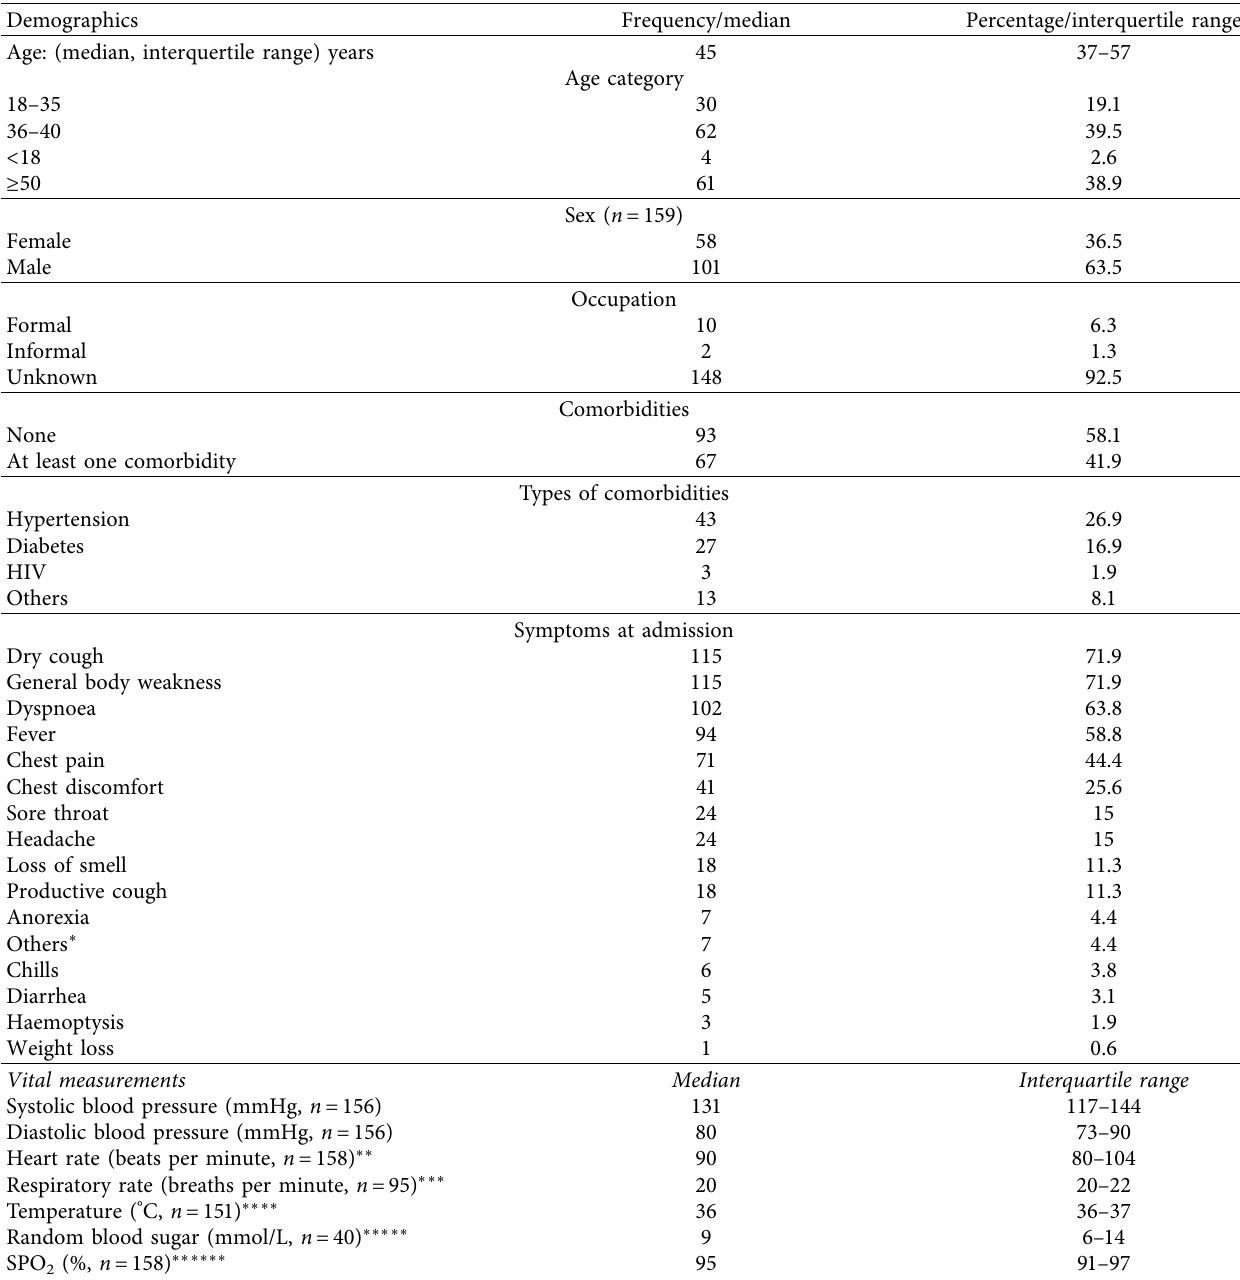
Table 1: Demographic and clinical characteristics at admission among participants with confirmed COVID-19 at case hospital.